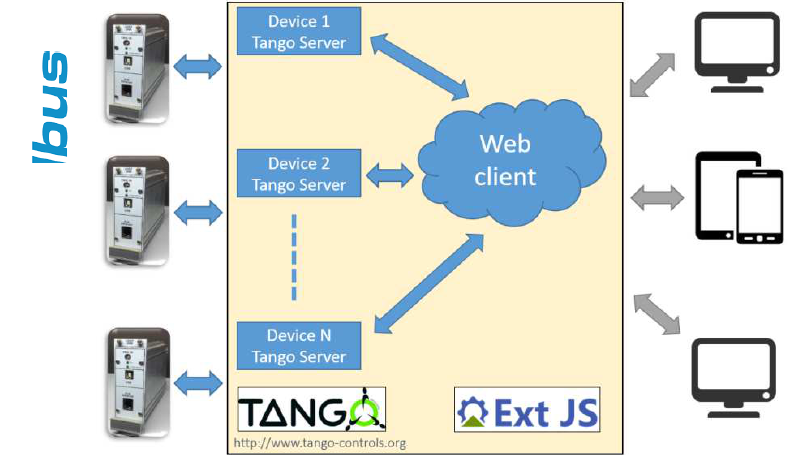
Figure 3. The injection beam profiles measurement system block